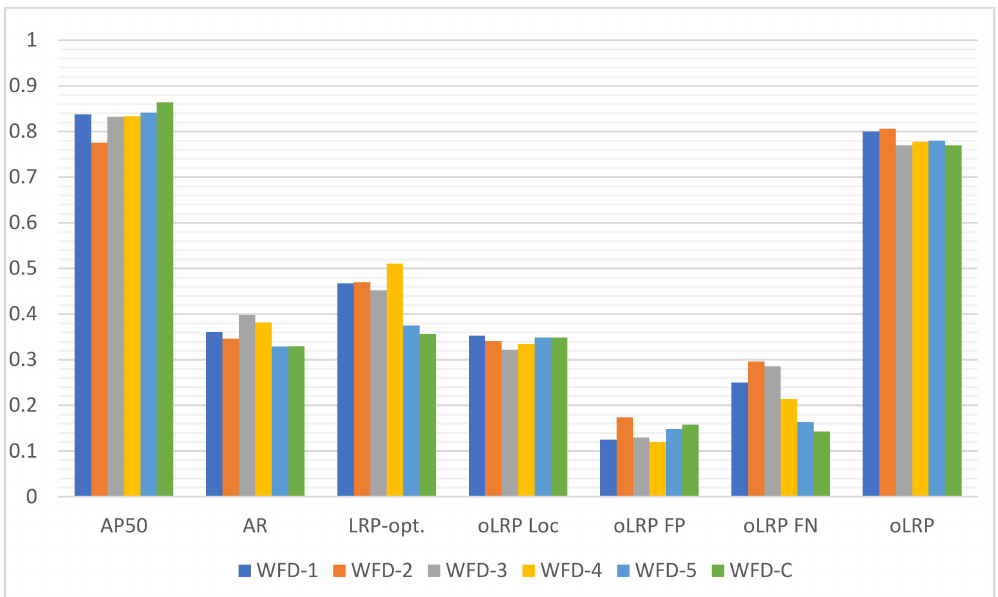
Figure 19. Results (AP50, AR, LRP-optimal threshold (LRPt), oLRPLoc (oLRPL), oLRPFP and oLRPFN) of Ensemble Model (WFD-1, WFD-2, WFD-3, WFD-4, WFD-5, WFD-C).